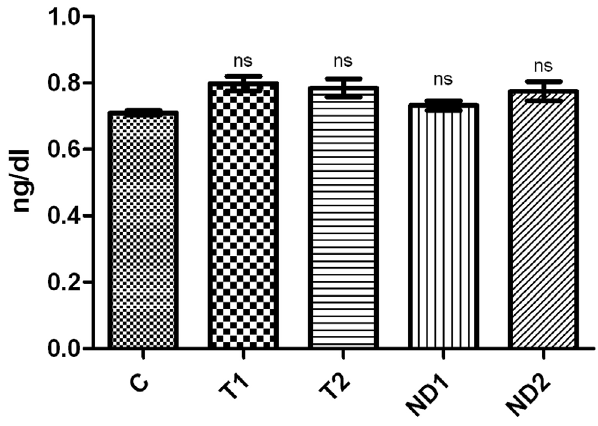
Figure 12. Effect of T and ND on serum free T 4